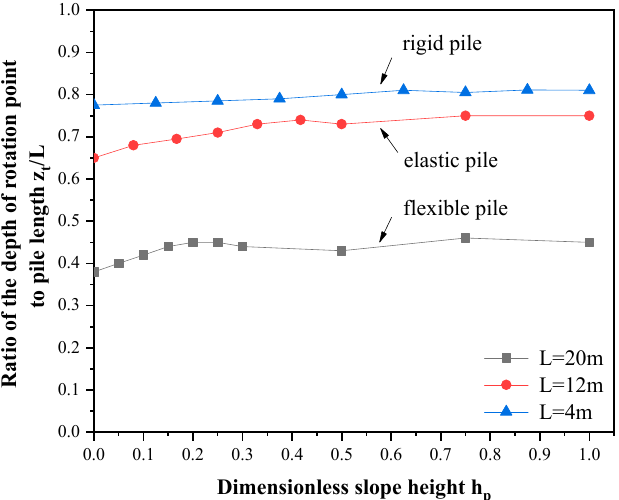
Figure 14. The variation of the 𝑧 (cid:2930) /𝐿 with ℎ (cid:2926) derived by FEA.